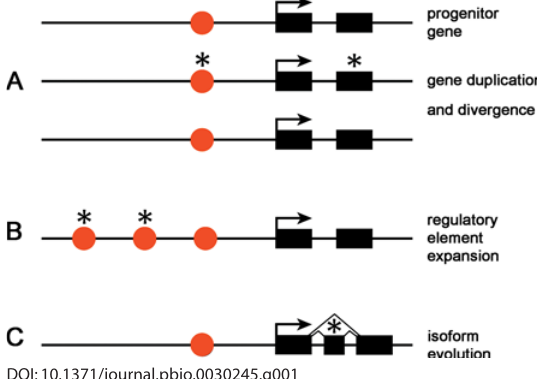
DOI: 10.1371/journal.pbio.0030245.g001 Figure 1. Different Modes of Gene Evolution Increase the Diversity of Gene Function and Minimize Pleiotropy The function of a progenitor gene with the simple structure of one cis -regulatory element (red circle) and a pair of exons (black rectangles) can be expanded and diversifi ed in several ways. (A) Gene duplication followed by mutations (asterisks) in either coding or regulatory sequences of the initially identical paralogs will produce genes that may be expressed in different ways or proteins with distinct functions, while the original function can be maintained. (B) An expansion in the number of cis -regulatory elements by any of a number of means (transposition, rearrangement, duplication, point mutation) can expand the number of tissues in which the gene is active, but preserves the original function. (C) The evolution of a new exon and splicing sites creates the potential for alternative forms of a protein to be made. Mutations in alternative exons (asterisks) need not affect the original function of the